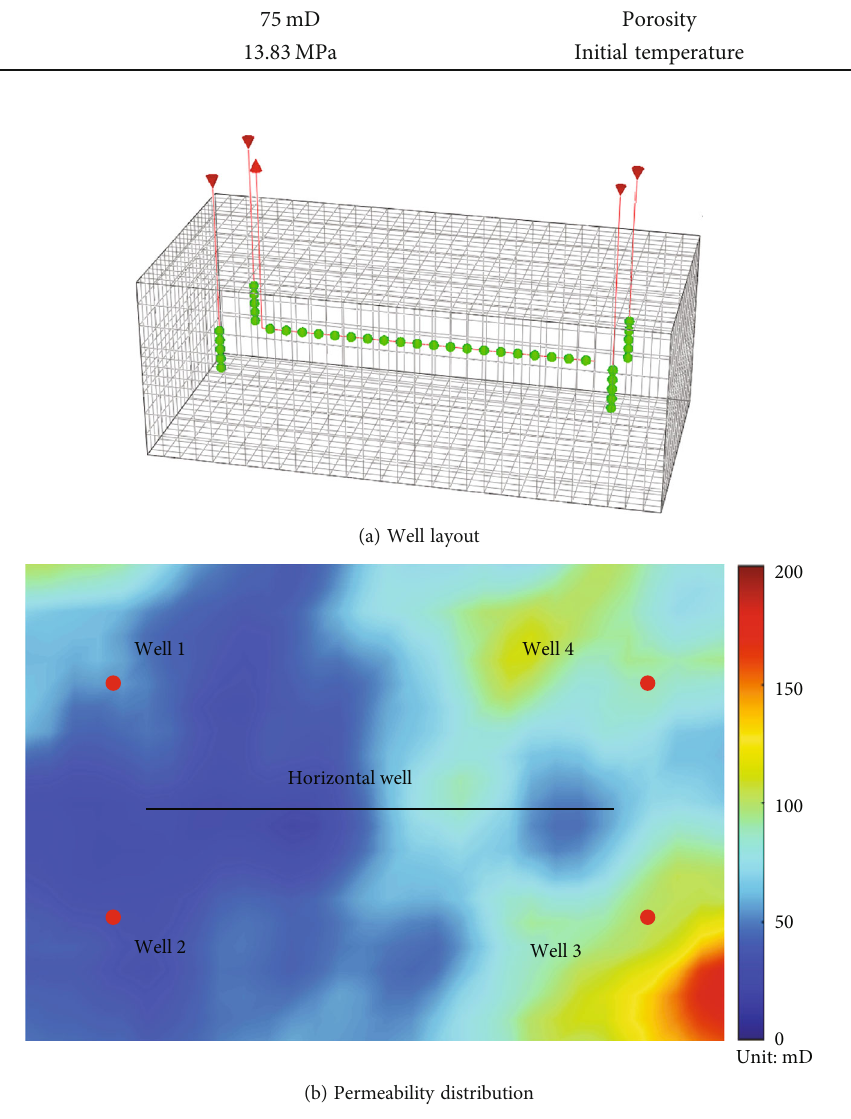
Figure 4: Physical model of numerical simulation and permeability distribution.